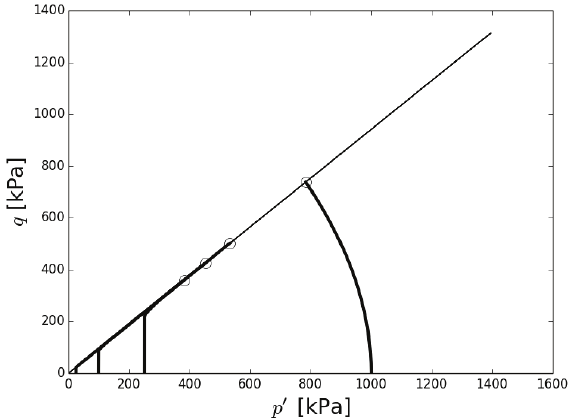
Fig. 4. Shear characteristics q – ε 1 resulting from the coupled model, obtained for OCR = 1, 4 and ψ = 2 °